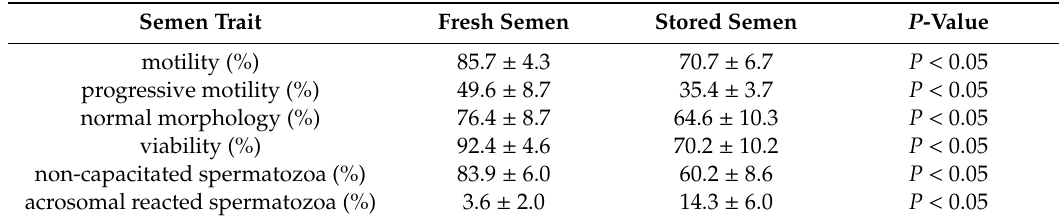
Table 1. Sperm characteristics (mean ± standard deviation (SD)) of fresh semen and semen after 72 h of liquid preservation at 15–17 ◦